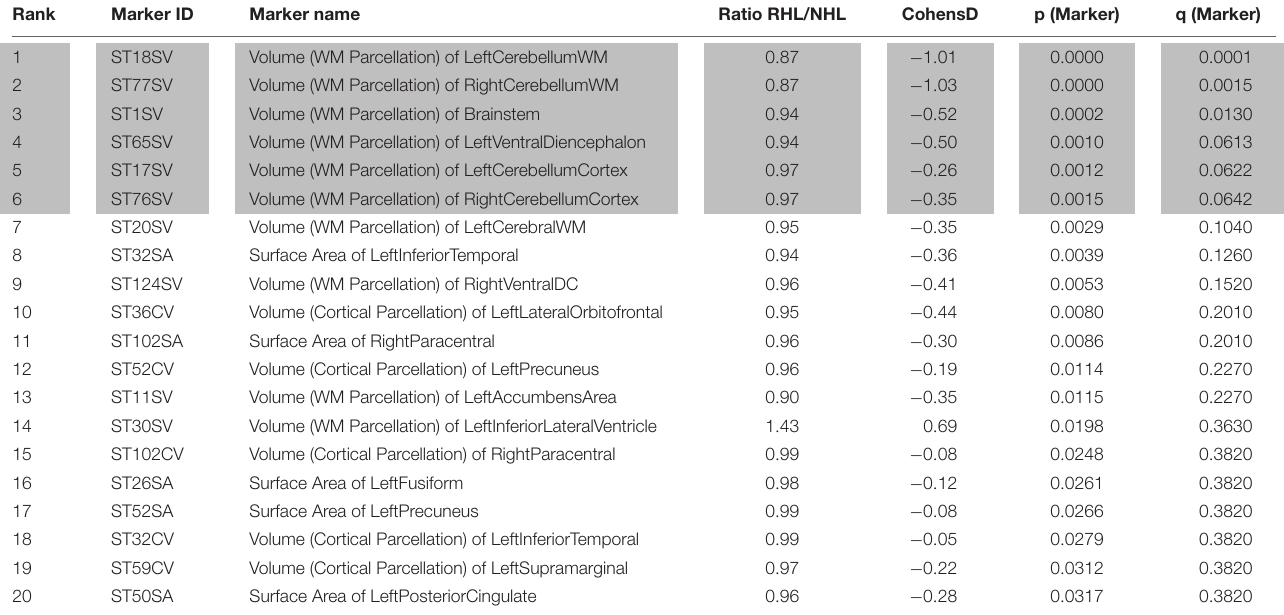
TABLE 4 | Top 20 markers, based on p and q -values, differentiating HL from NHL in AD subjects, corrected for age and gender.